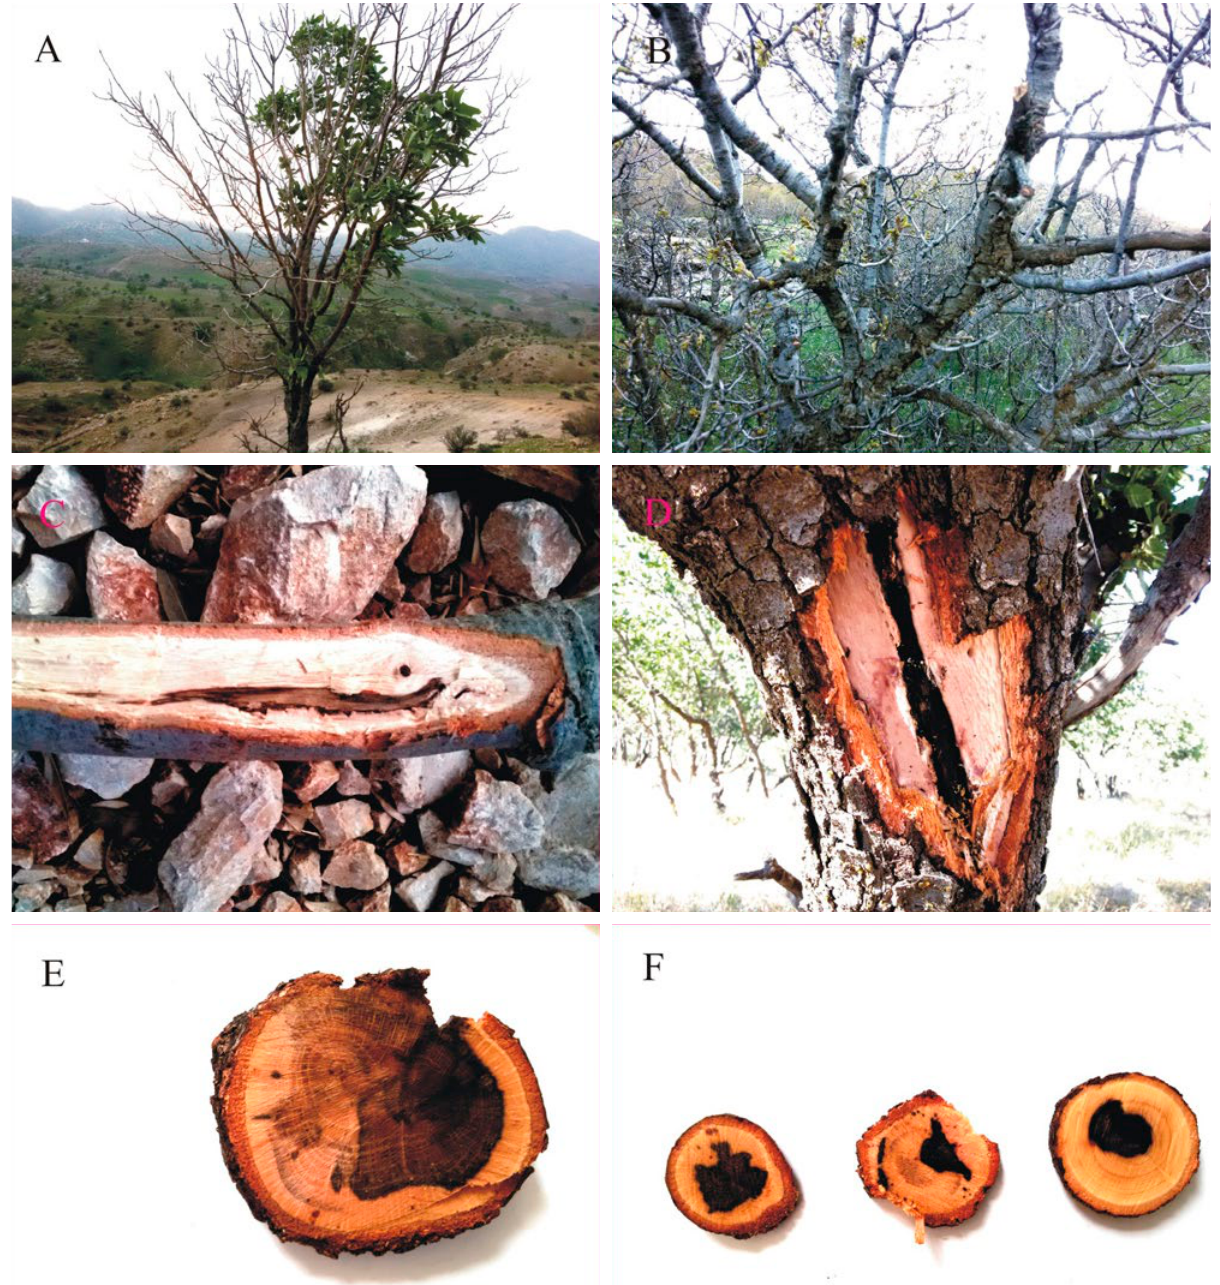
Figure 1. Symptoms of dieback and decline (A and B), canker (C and D, longitudinal sections), and watery necrosis and back staining (E and F cross sections), caused by Neoscytalidium novaehollandiae on Persian oak trees in